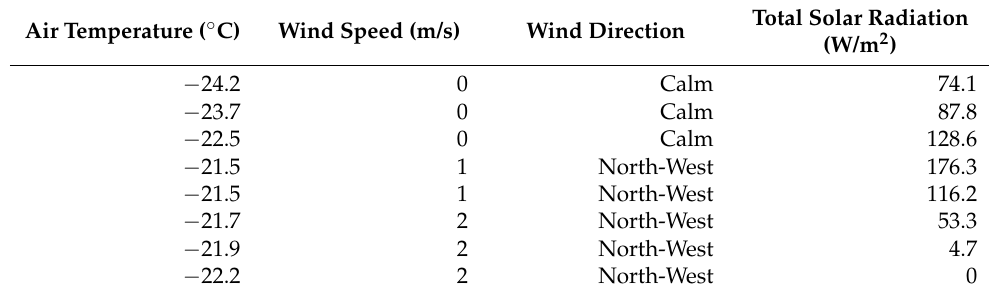
Figure 3. Searching the fragments (cid:101) Z 1 ( l ) , (cid:101) Z 2 ( l ) , (cid:101) Z 3 ( l ) , etc. that are similar to Z ( l ) . The fragment of four-dimensional time series used as retrospective data in experiments is demonstrated in Table 1. Wind directions are “Calm”, “North”, “North-West”, “North- East”, “South”, “South-West”, “South-East”, “West”, and “East”. Upon request, the data are available from the external WPS service registered on the GIS portal. This WPS service performs preliminary data processing extracted from the open data source https://rp5.ru/ Weather_in_the_world (accessed on 29 October 2021) for a given period. Table 1. Fragment of multidimensional time